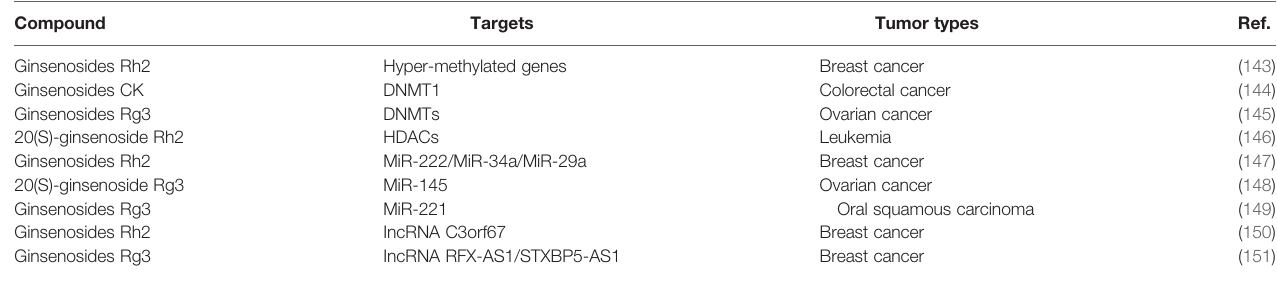
TABLE 6 | Ginsenosides target epigenetic enzymes against cancers.